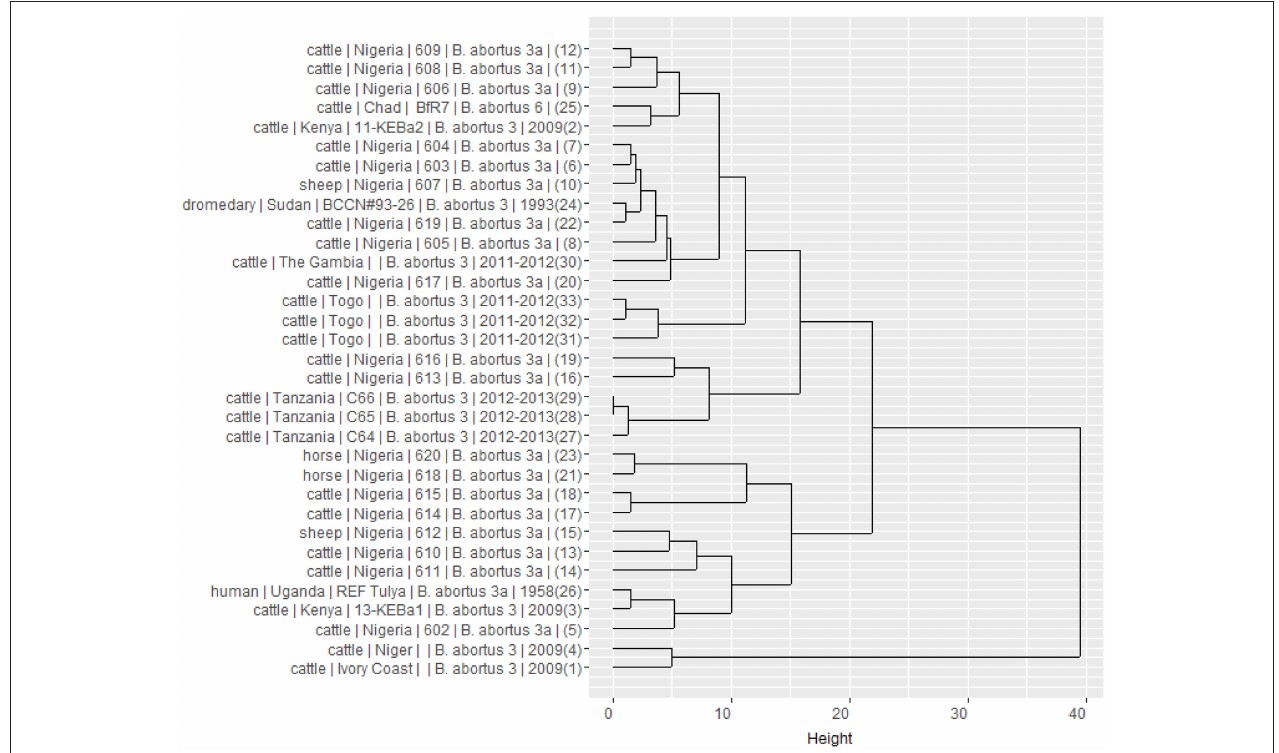
FIGURE 3 | Dendrogram clustered MLVA profiles showing the relation between the 25 West African isolates of B. abortus biovar 3 and eight neighbor profiles from Africa retrieved in the literature and from the Brucella MLVA bank. It is built from results of a Ward linkage cluster analysis of the number of variable tandem repeats (VNTR) of the MLVA 16 loci. For each strain, information on host, country of origin, strain reference, species and biovar, year of isolation (when available) and number of order in the database are